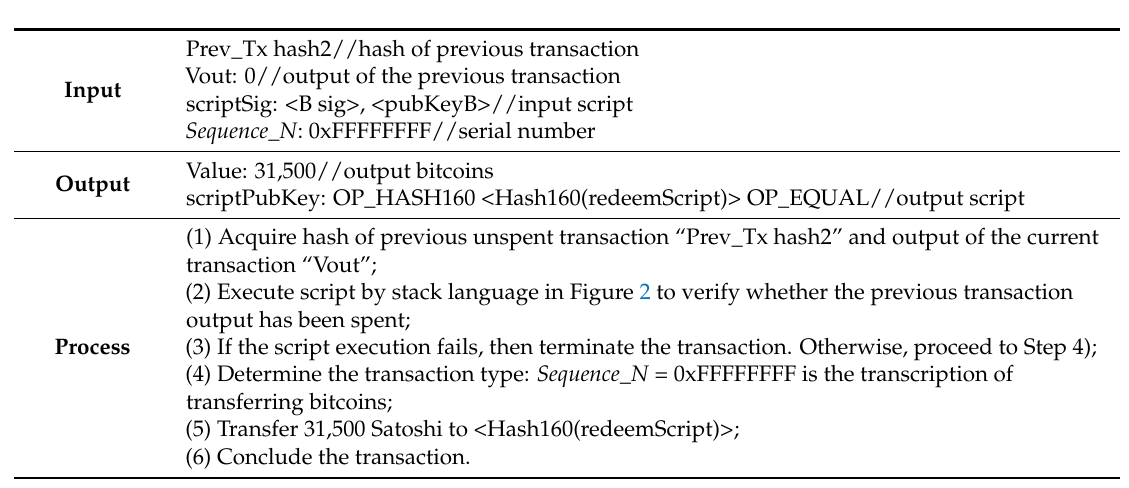
Table 4. Transaction of transferring bitcoins.